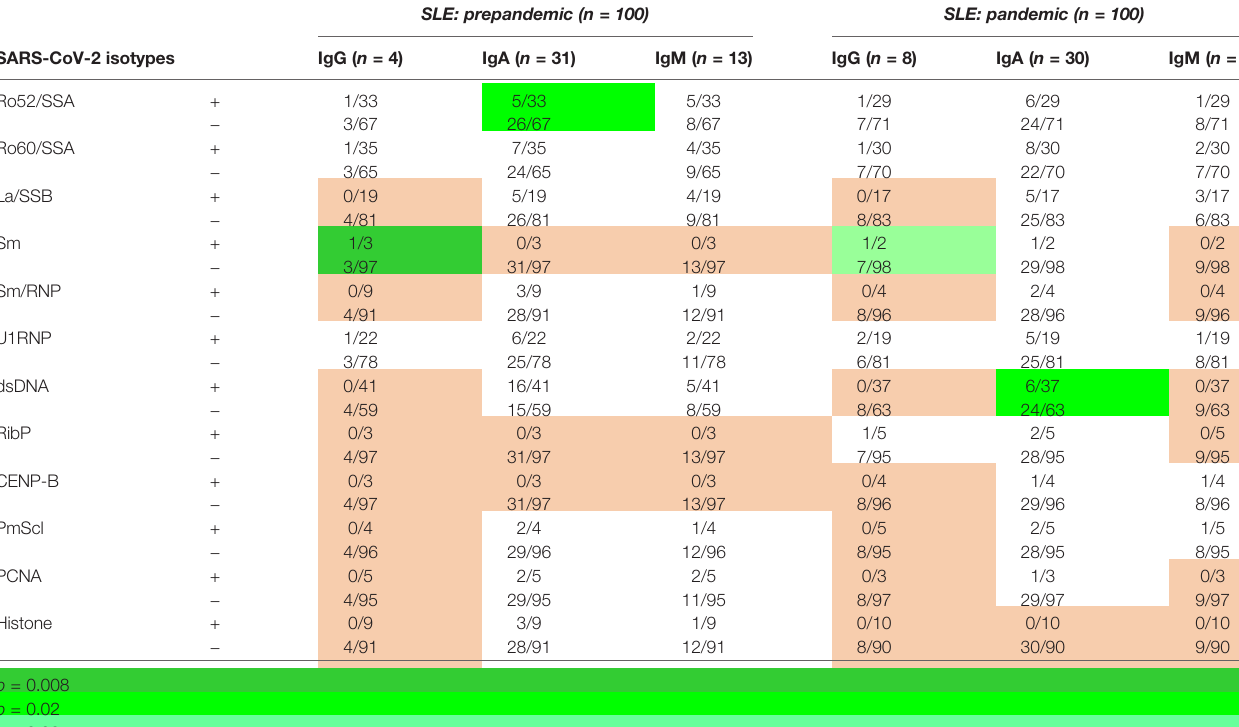
TABLE 4 | Associations between ANA speci fi cities and SARS-CoV-2 antibody isotypes in SLE patients before and during the pandemic. SLE: prepandemic (n = 100) SLE: pandemic (n = 100) SARS-CoV-2